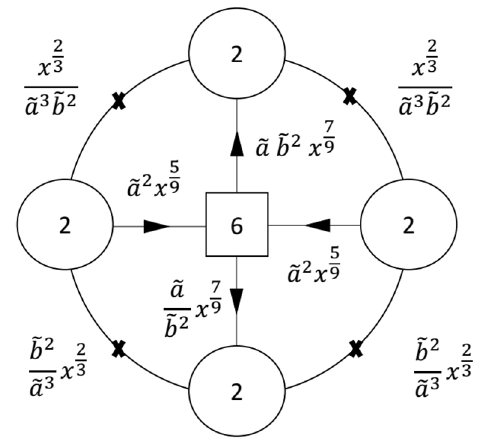
Figure 12 . The model in figure (b) after the introduction of monopole superpotentials associated with the basic monopole operators of the left and right SU(2) groups. Additionally, there are cubic superpotentials running along the perimeters of the internal